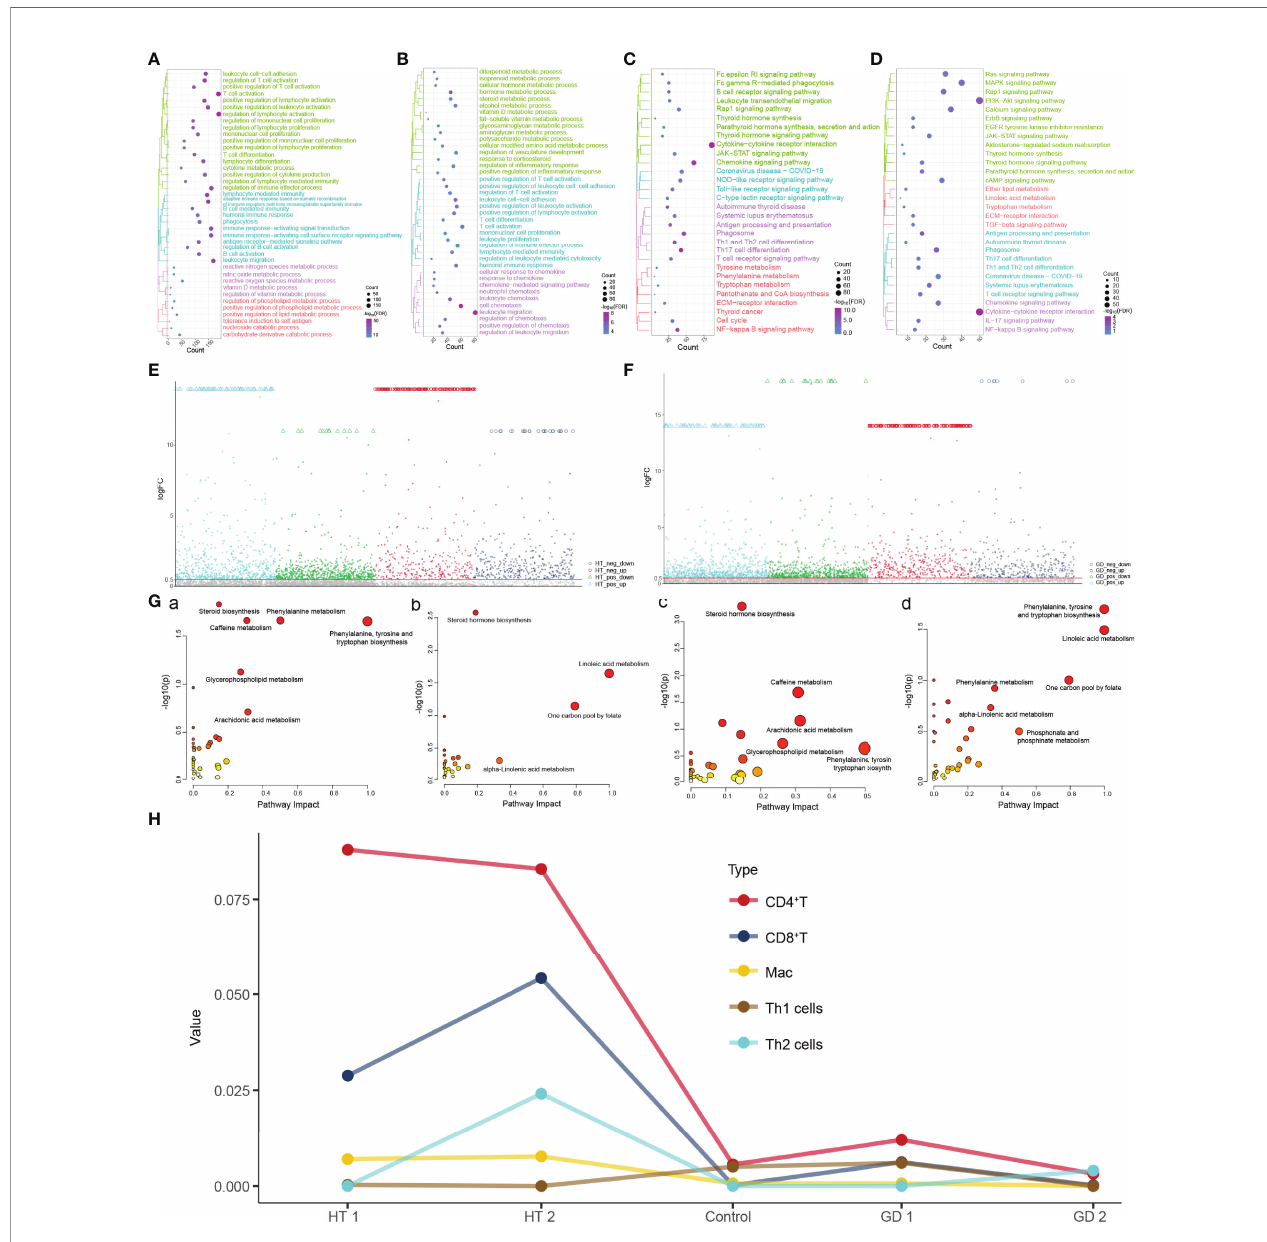
FIGURE 3 | Dysregulated gene expression in HT and GD is associated with abnormal immune cascade and metabolic signaling. (A, B) Biological processes signi fi cantly involved in high-con fi dence dysregulated expression genes in HT (A) and GD (B) patients. (C, D) KEGG pathways signi fi cantly involved in high-con fi dence dysregulated expression genes in HT (C) and GD (D) patients. (E, F) Manhattan plot showing differential metabolites in HT (E) and GD (F) patients relative to controls, logFC >0.5. (G) (a) Metabolic signaling pathways activated in HT; (b) metabolic signaling pathways inhibited in HT; (c) metabolic signaling pathways activated in GD; and (d) metabolic signaling pathways inhibited in GD. (H) Estimation of immune in fi ltration in patients with HT and GD. FDR, false discovery rate; GD, Graves ’ disease; HT, Hashimoto ’ s thyroiditis; Mac,